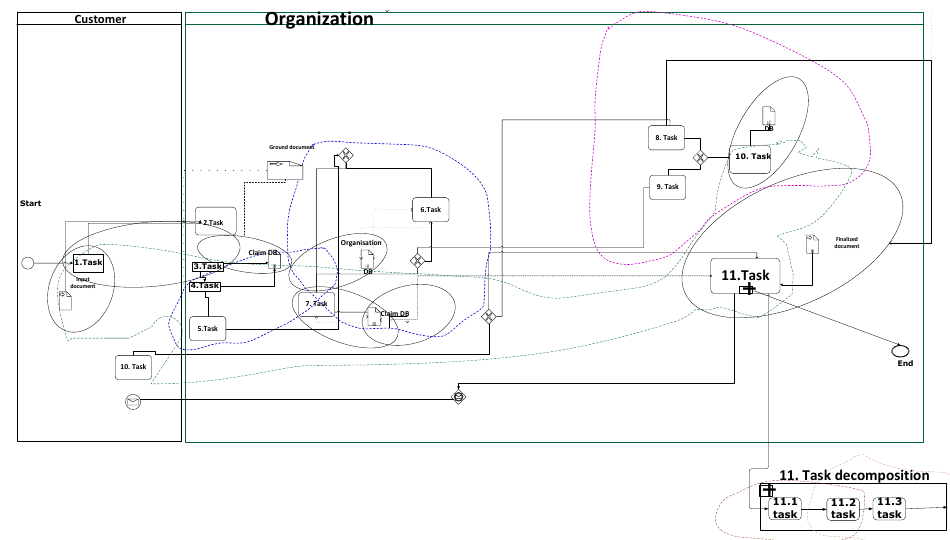
Figure 12. A real workflow; business process description abstracted